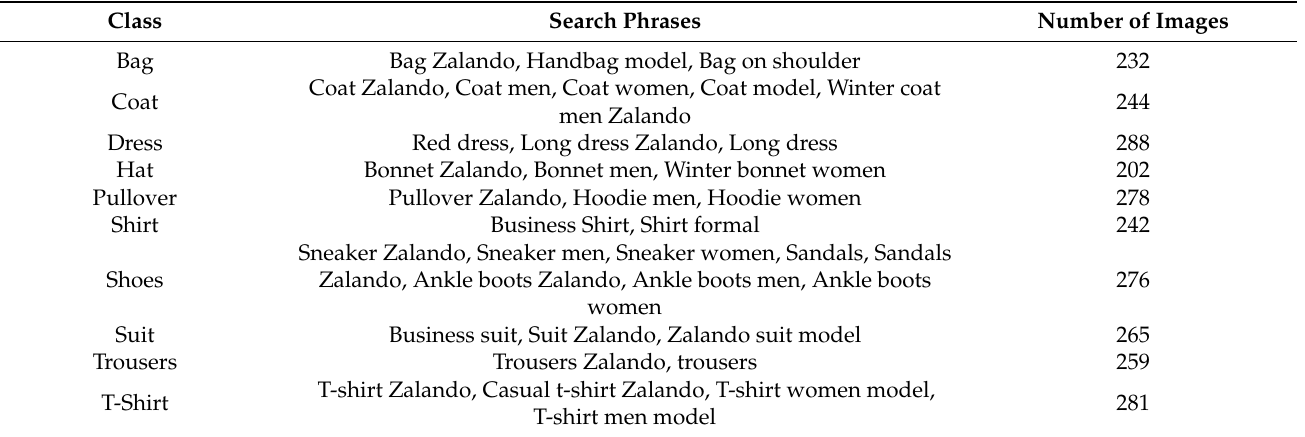
Table 2. Google search phrases for each class for the collection of the